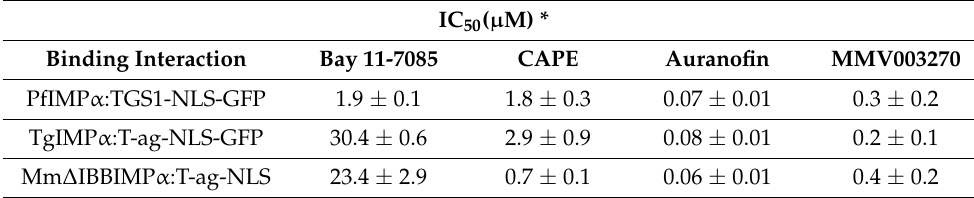
Table 2. Summary of the IC 50 values for inhibition of IMP α :NLS